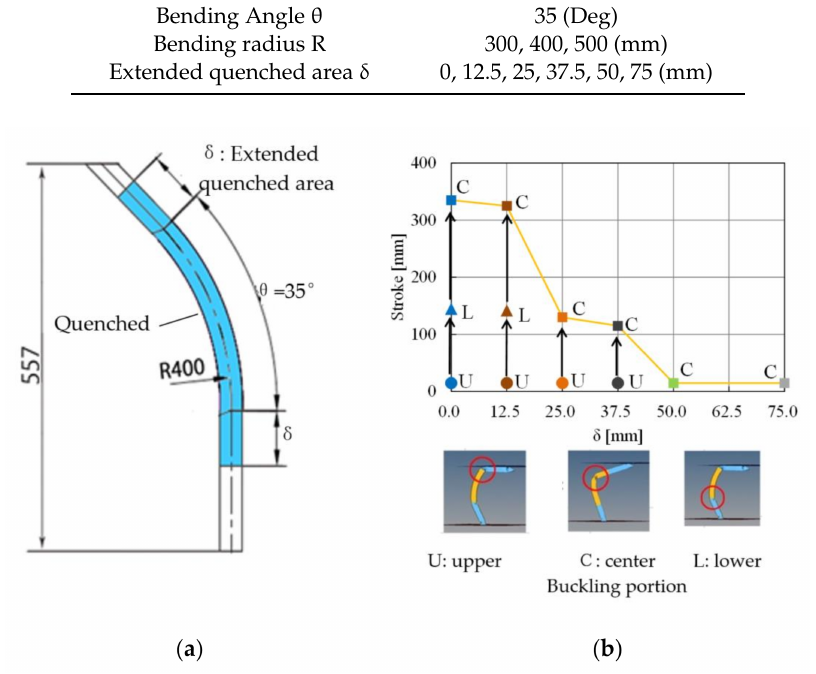
Figure 16. Relationship between extended quenched area and the stroke at buckling occurred: ( a ) initial product shape and ( b ) calculation